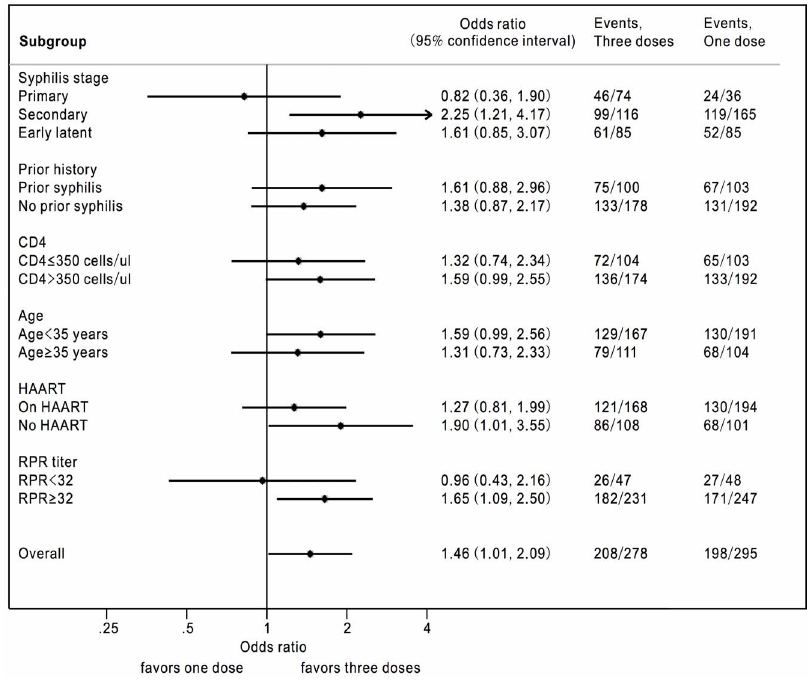
Figure 3. Forest plot showing the serological response rates in different subgroups of patients receiving 1 or 3 doses of benzathine penicillin G at 12 months of follow-up.